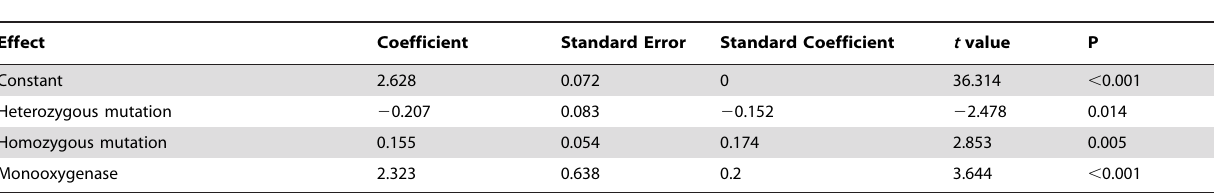
Table 4. Summary results of stepwise multivariate regression analysis on knockdown time in Anopheles sinensis .